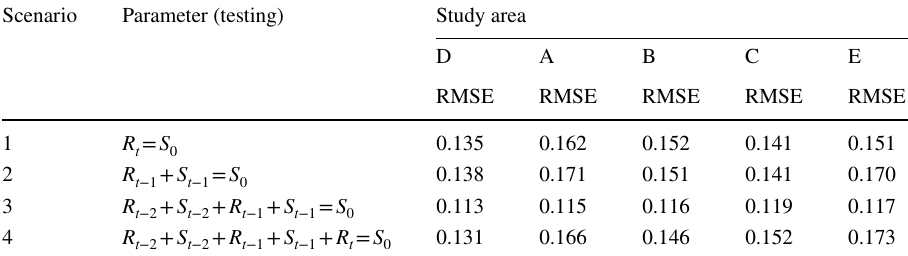
Table 7 Results of trial and error for all scenarios in each study